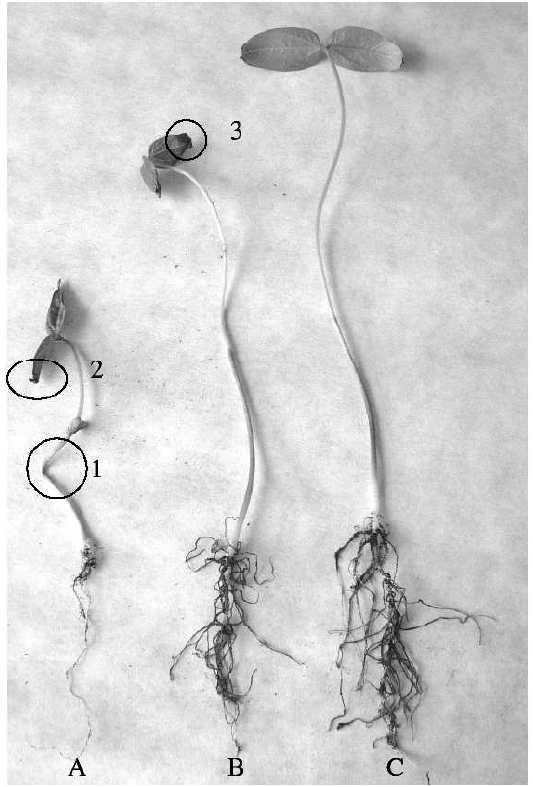
Figure 1. The mung bean cultivated in control soil (A), soil with 0.5% mineral addition (B) and 2%